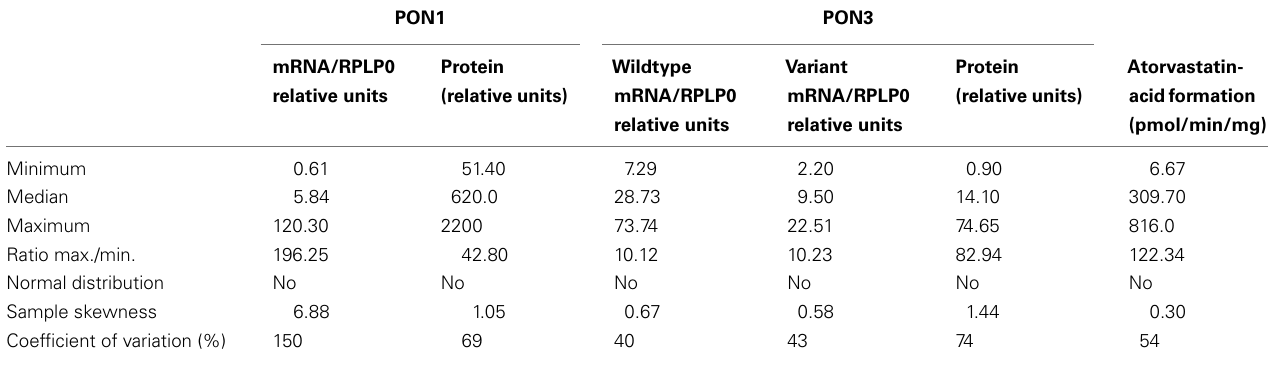
Table 2 | Population variability of hepatic PON1 and PON3 expression